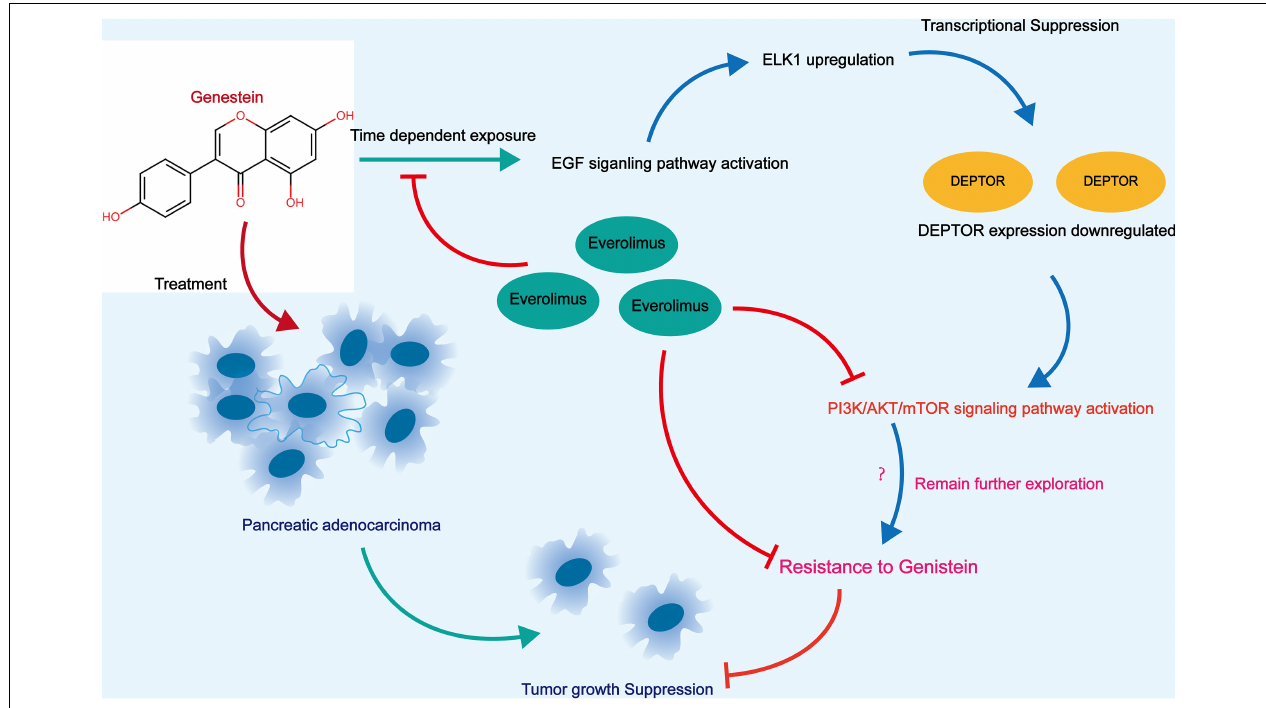
FIGURE 8 | A graphical abstract for the molecular mechanism. In genistein-resistant PC cells, the suppressive effect of genistein on EGFR signaling was blocked. The downstream molecule ELK1 induces DEPTOR downregulation and enhances mTOR phosphorylation, which further leads to increased genistein resistance in cells. Treatment of ELM or artificial downregulation ELK1 may block the mTOR phosphorylation and enhance the genistein sensitivity in